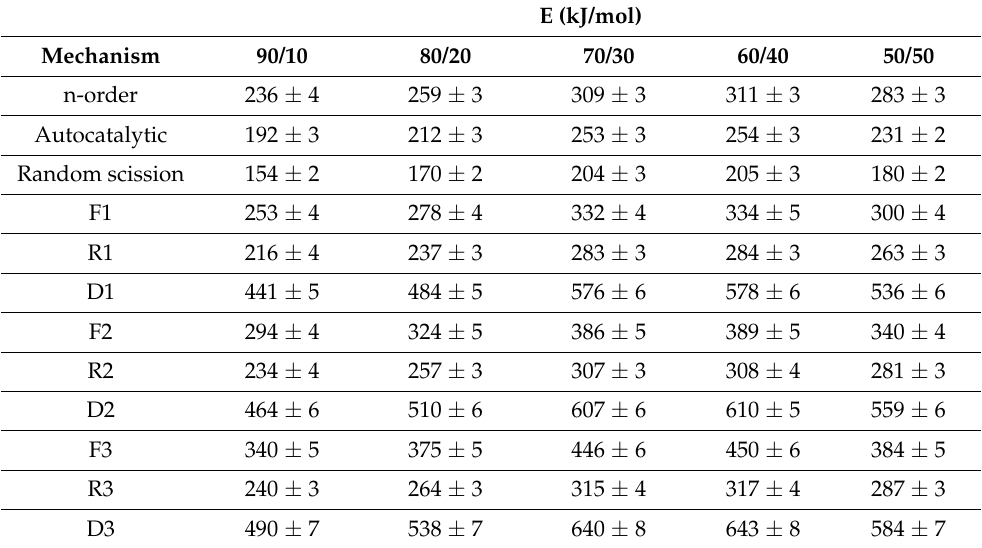
Table 3. Mean activation energies of the thermal degradation of PLA, obtained using the general analytical equation at various heating rates, for PLA/PA bioblends containing from 50% to 90% PLA.